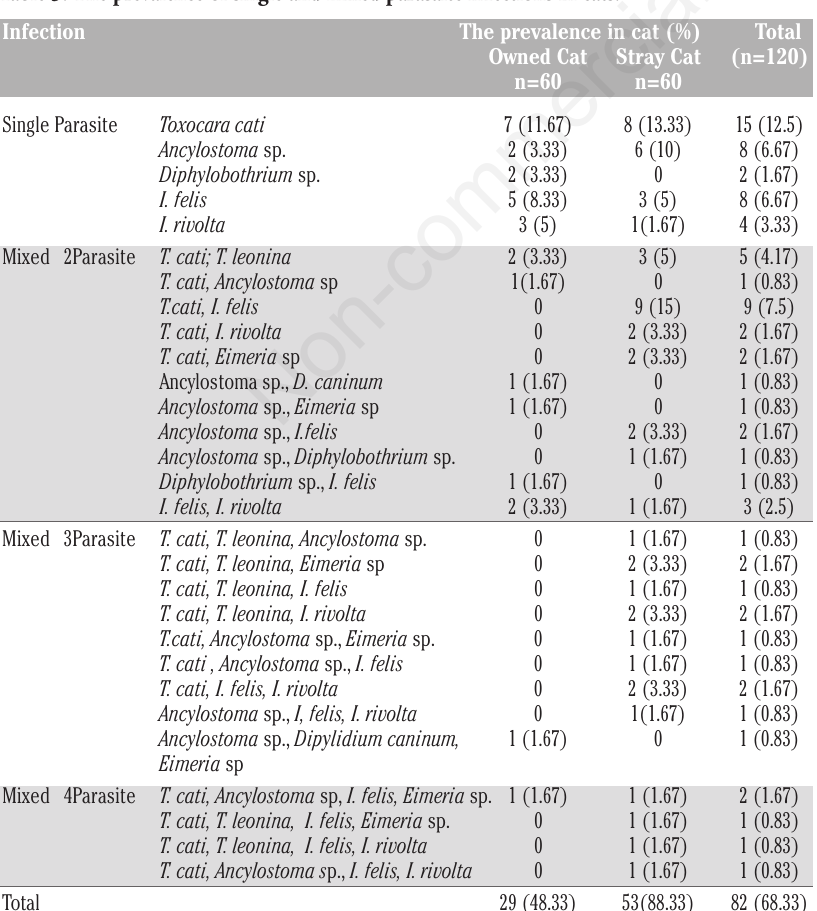
Table 3. The prevalence of single and mixed parasaite infections in cats. Infection The prevalence in cat (%) Total Owned